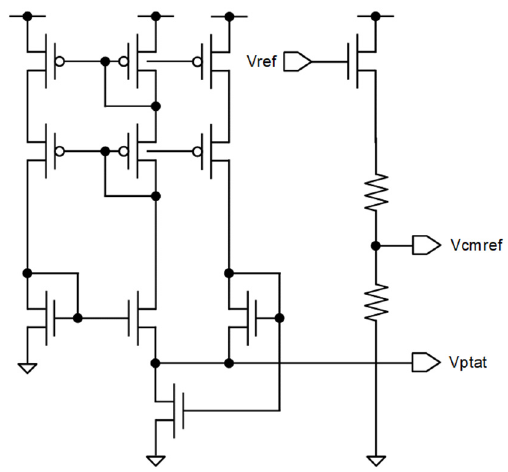
Figure 11. A simplified schematic diagram of the voltage source proportional to absolute temperature.